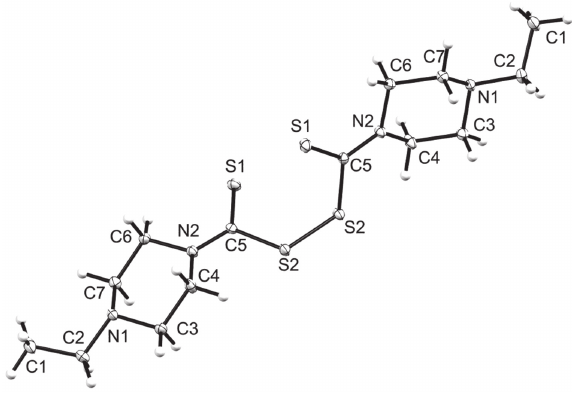
Table 2: Fractional atomic coordinates and isotropic or equivalent isotropic displacement parameters (Å 2